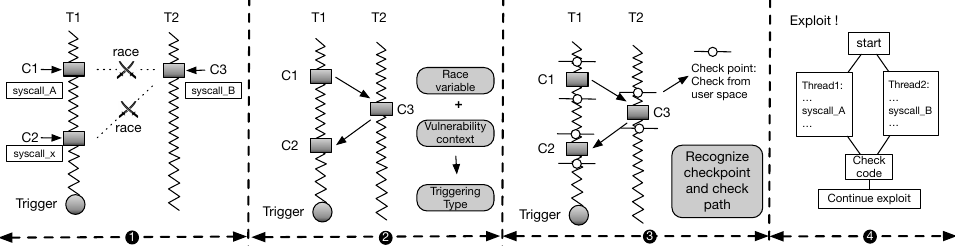
Figure 1. The typical workflow of crafting a working exploit. (cid:202) Identify the race instruction; (cid:203) Determine the timing relationship of the race instruction and the triggering type and select the appropriate exploitation method; (cid:204) Determine how to check whether the race condition and heap spraying are satisfied; (cid:205) Construct the exploit. Note that the zigzag line indicates the kernel execution, and syscall_A and syscall_B denote the system calls that are attached to the occurrence of the race points in the two threads, T1 and T2. syscall_x can be syscall_A or another system